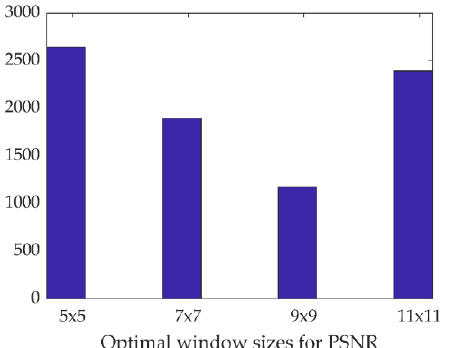
Figure 5. Numbers of test images with different optimal window sizes according to PSNR.